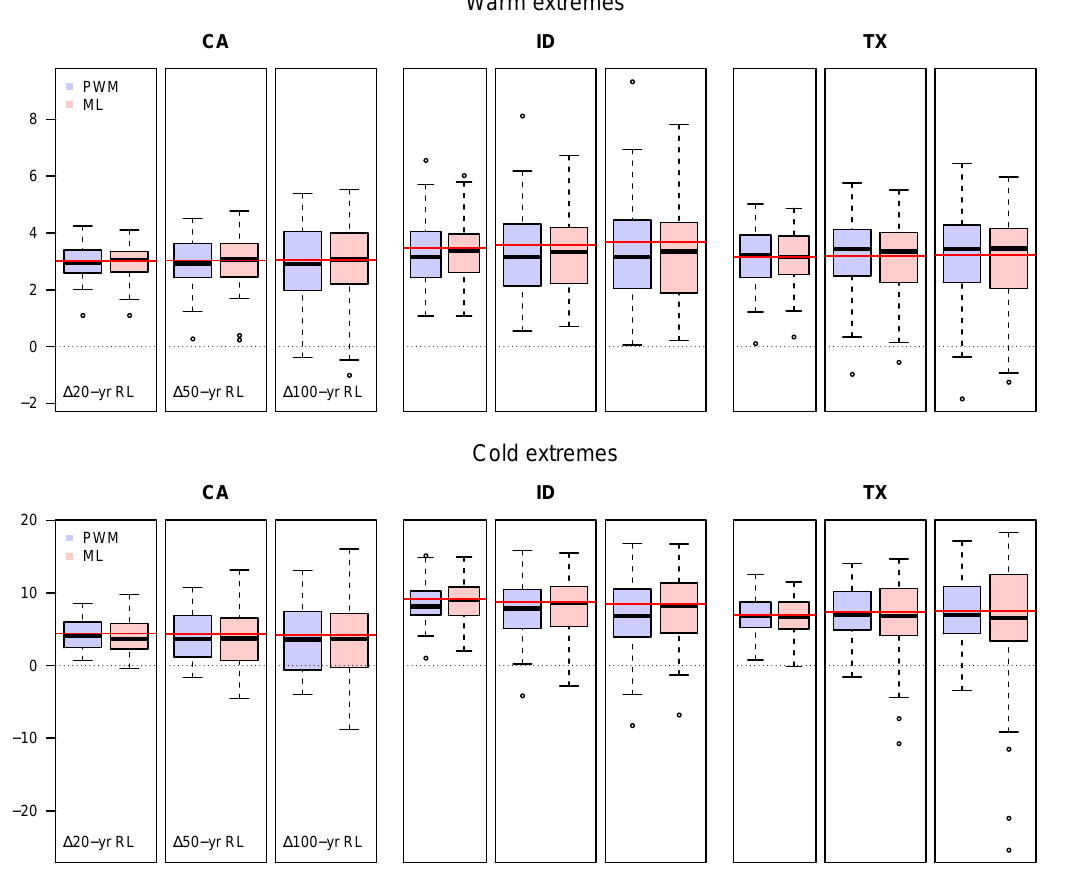
Figure D1. Boxplots of estimated changes in 20-, 50-, and 100-year return levels obtained with two estimation procedures, PWM (blue) and ML (red), for three example locations. Results are generally similar, but PWM does avoid extreme outliers produced by ML for cold extremes in one location